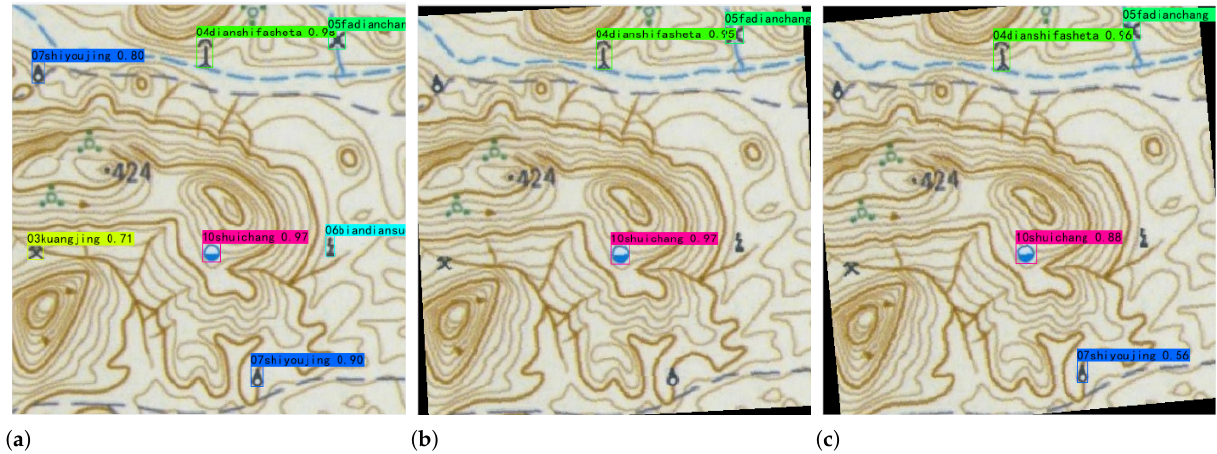
Figure 24. Statistical plots of different rotation angles on our test set.